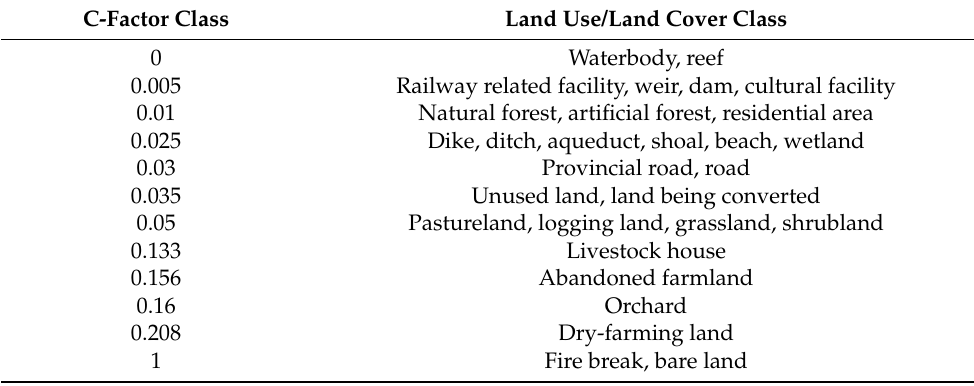
Figure 2. LULC classes of the study area (forests are labeled in white for contrasting other LULC classes). Table 4. LULC classes merged by C-factor classes (revised from Jhan [29] and Lin